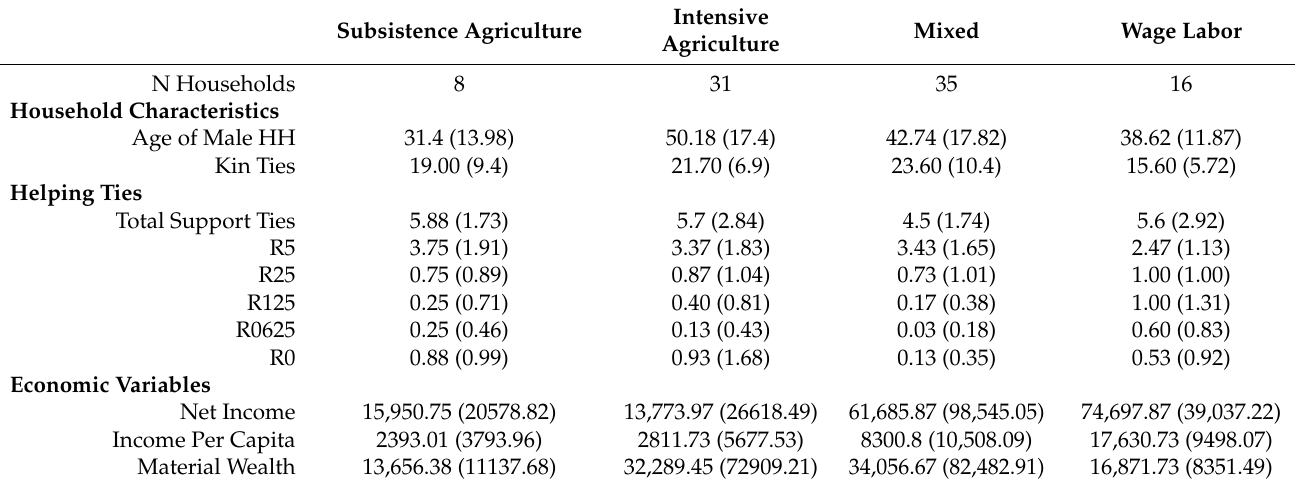
Table 1. Household-Level Variable Descriptives—Means (Std.